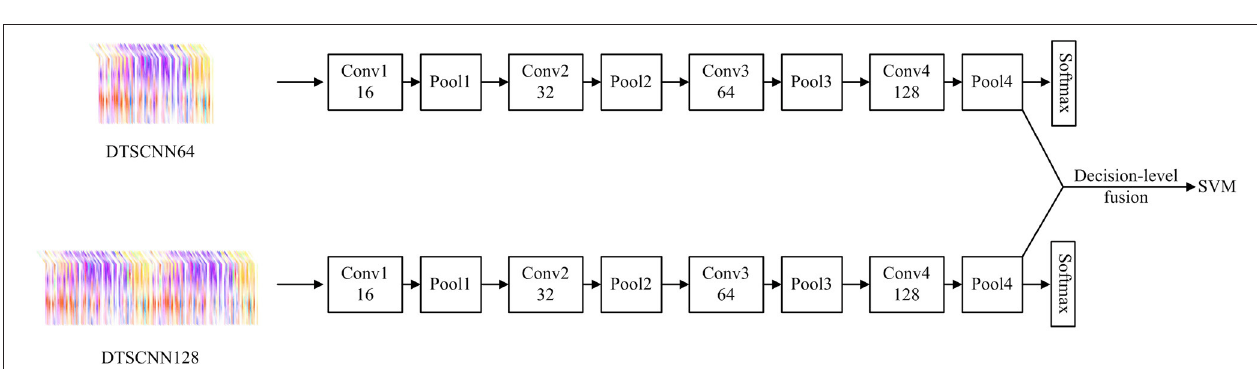
FIGURE 3 | Fusion model. Left : Late Fusion. Middle : Early Fusion. Right : Slow Fusion. The red, green, blue, and purple box represent convolutional, pooling, normalization and Fully-Connected (FC) layers, respectively.